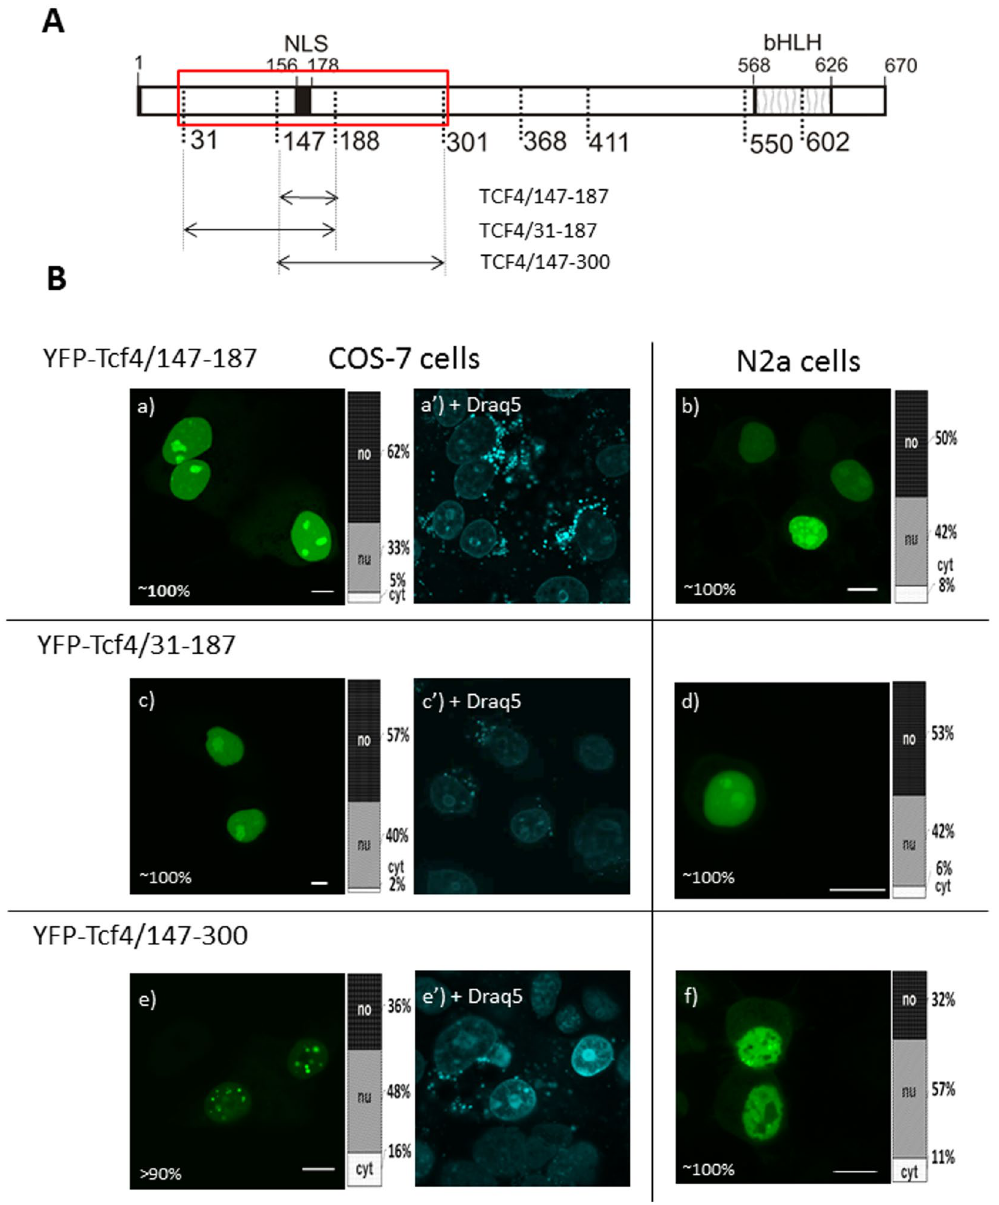
Figure 3. Subcellular distribution of deletion mutants (147-300aa) of TCF4 ( A ) Schematic representation of TCF4 protein. Region of the studied area of TCF4 is shown by the red rectangle. Expressed deletion mutants of TCF4 are depicted as arrows. The length of each domain in the diagram is arbitrary. ( B ) Subcellular distribution of deletion mutants of TCF4. Subcellular localizations of the expressed proteins were analysed by confocal microscopy 20-24 h after transfecting COS-7 and N2a cells. Representative images (single confocal plane) of subcellular distribution of the derivatives of the TCF4/31-300 area. Bar, 10 µ m. Draq5 was added to the cells for DNA visualization. Ratios between mean fluorescence intensity in cytoplasmic, nuclear and nucleolar compartments are presented as an accumulated bar graph (no- nucleolus; nu- nucleus, cyt- cytoplasm). (a,a’,b) YFP-TCF4/147-187, (c,c’,d) YFP-TCF4/31-187, (e-f)